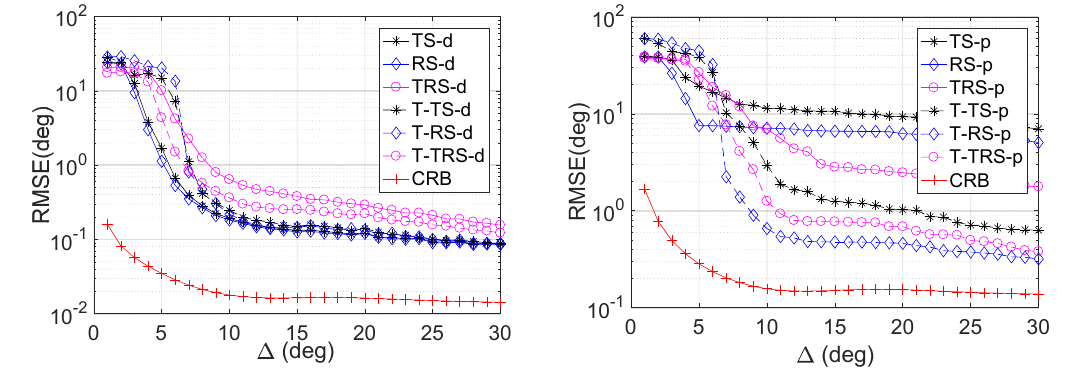
Δ in Case (I). Figure 7. RMSE comparisons versus target distance ∆ in Case